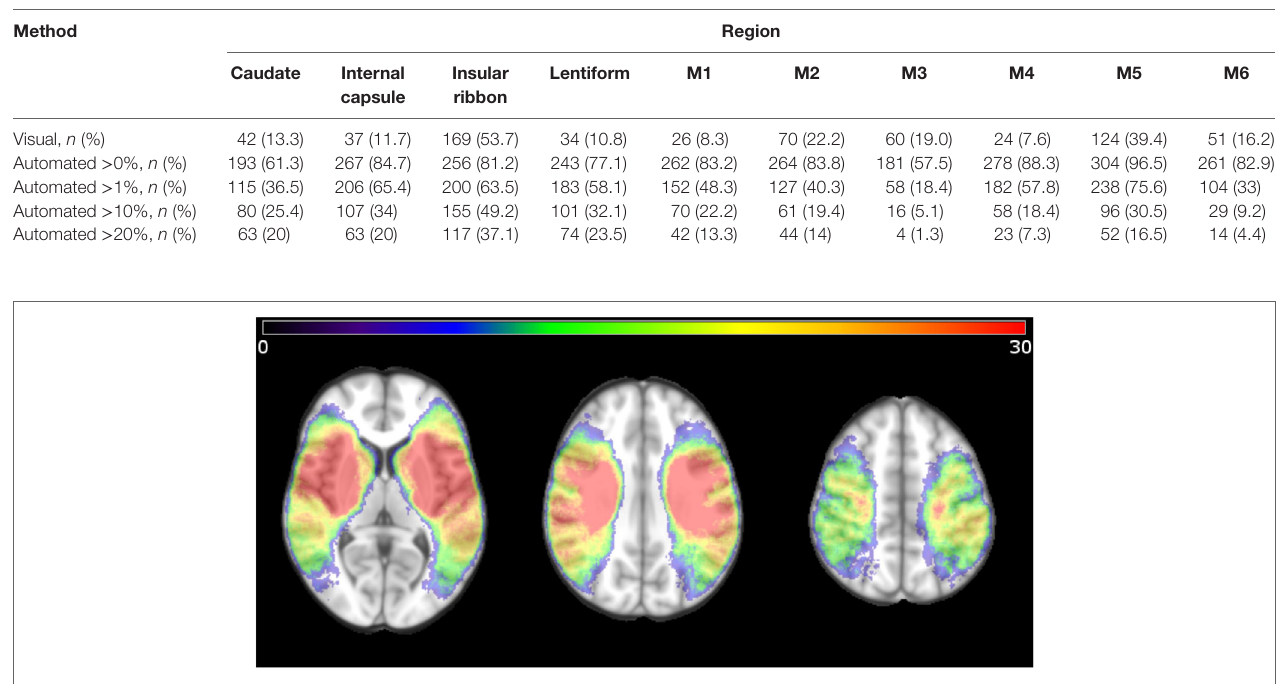
TaBle 1 | Absolute numbers and percentage of all 315 patients with lesions in the respective Alberta Stroke Program Early Computed Tomography Score (ASPECTS) region using visual and automated scoring